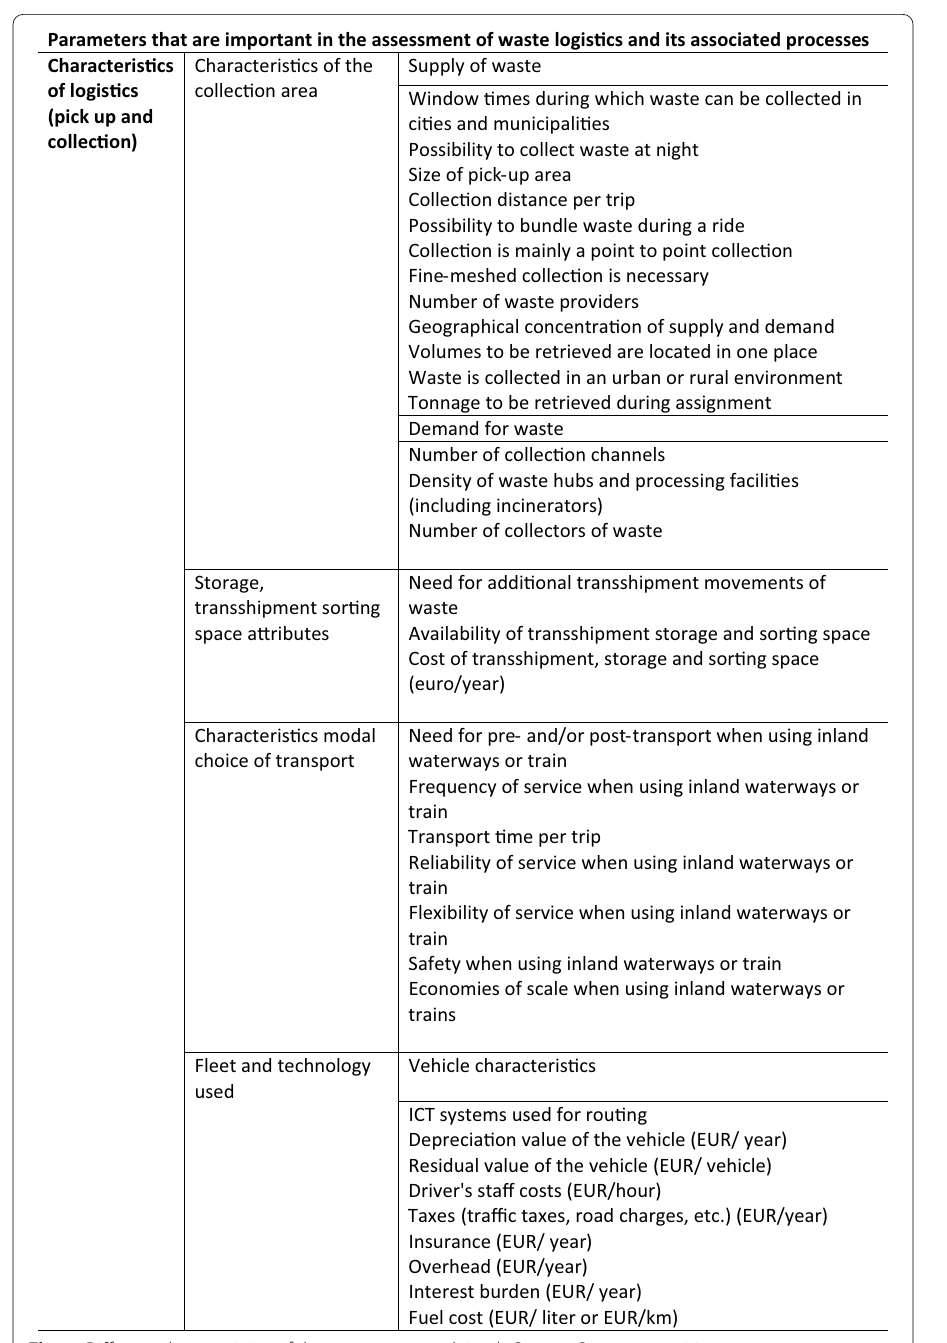
Step 3: determining the joint effect of the changed parameters on the total logistics costs, waste treatment, and sustainability aspects